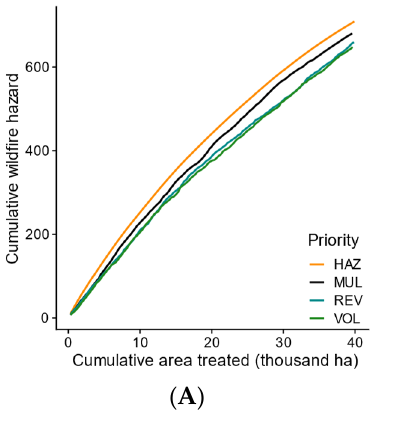
Figure 6. Comparison of solutions obtained under single versus multi-objective priorities for three response metrics ( A ) cumulative wildfire hazard, ( B ) cumulative merchantable volume, and ( C ) cu- mulative revenue, with increasing area treated and projects implemented. All outputs are from treating 300 ha per project. Note that within each panel, we graph the results of four scenarios where each of the priority objectives (lines) are maximized individually. For example, panel A shows the effect on treating wildfire hazard from four different prioritization